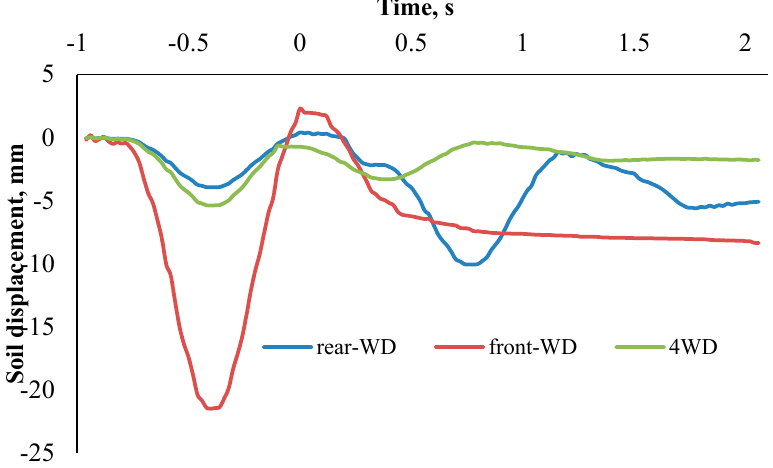
Figure 12. Soil displacement along the longitudinal (x) direction.